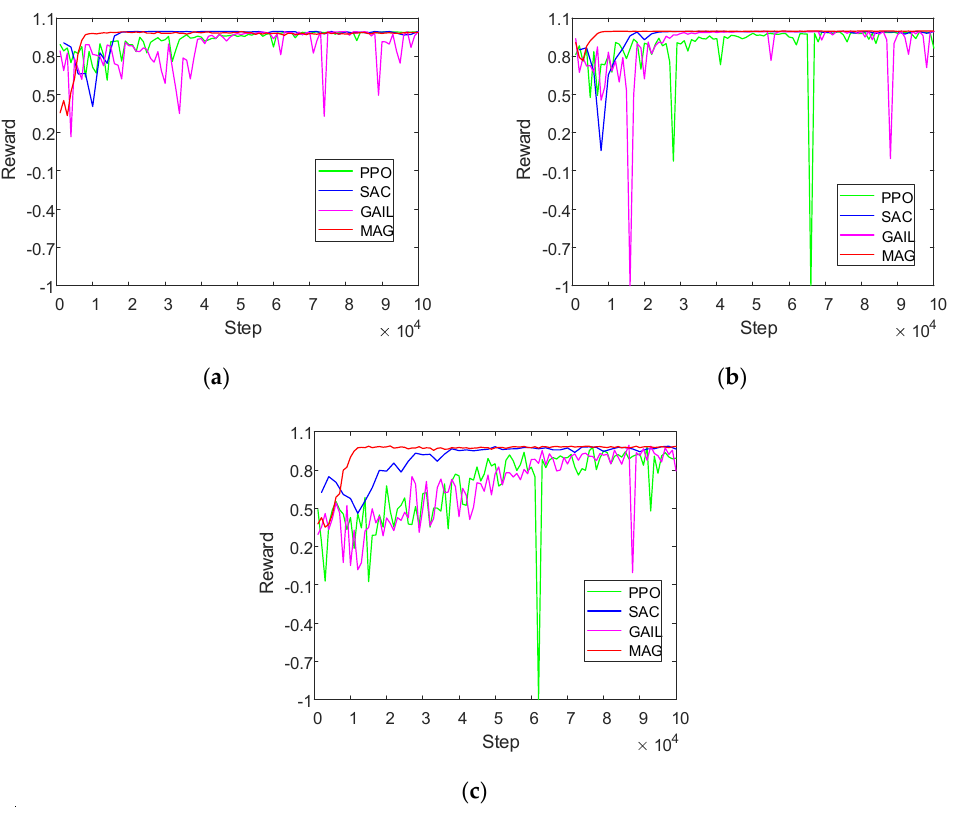
Figure 4. The reward obtained by the AUV using four methods in Scenes 1, 2, and 3: ( a ) Scene 1; ( b ) Scene 2; and ( c ) Scene 3.